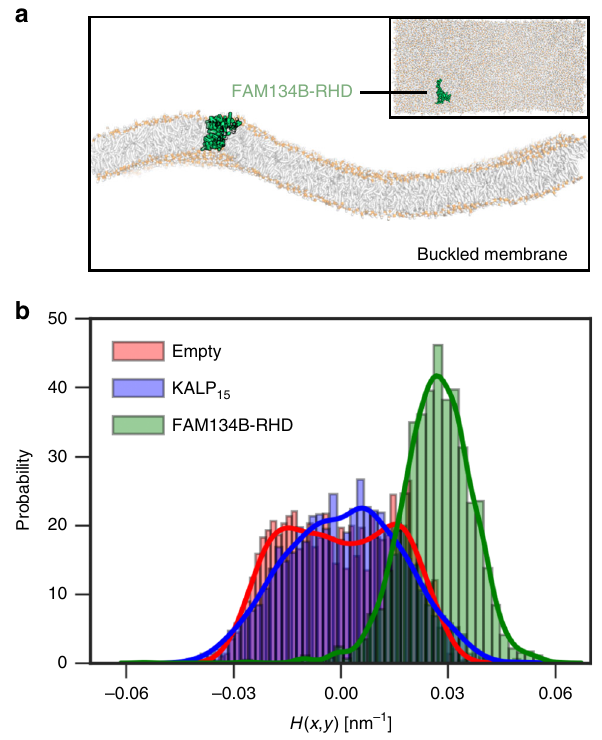
Fig. 4 Curvature sensing by FAM134B-RHD. a Cut through the simulation box along the xz plane (inset top view) showing the buckled lipid bilayer (orange phosphate beads), with excess area ( ≈ 17 nm 2 ) under edge compression. Diffusion of curvature-inducing proteins such as FAM134B- RHD (green) in the buckled membrane enables curvature sampling and estimation of intrinsic curvature preferences (see the section “ Methods ” ). We tracked the position of proteins ( x , y ) along the buckle, and quanti fi ed the curvature preference (principal, mean and Gaussian; see Supplementary Fig. 15). b Histograms of mean curvature, H ( x, y ), sampled by FAM134B-RHD (green) in coarse-grained simulations (1 ns intervals for 20 μ s) indicate a preference for highly curved regions of the buckle. By contrast, the KALP 15 peptide (blue) samples regions with lower curvature along the buckle. The local mean curvature fi eld of the empty buckled membrane (red) is obtained by random sampling of points in the xy plane (see Supplementary Fig.